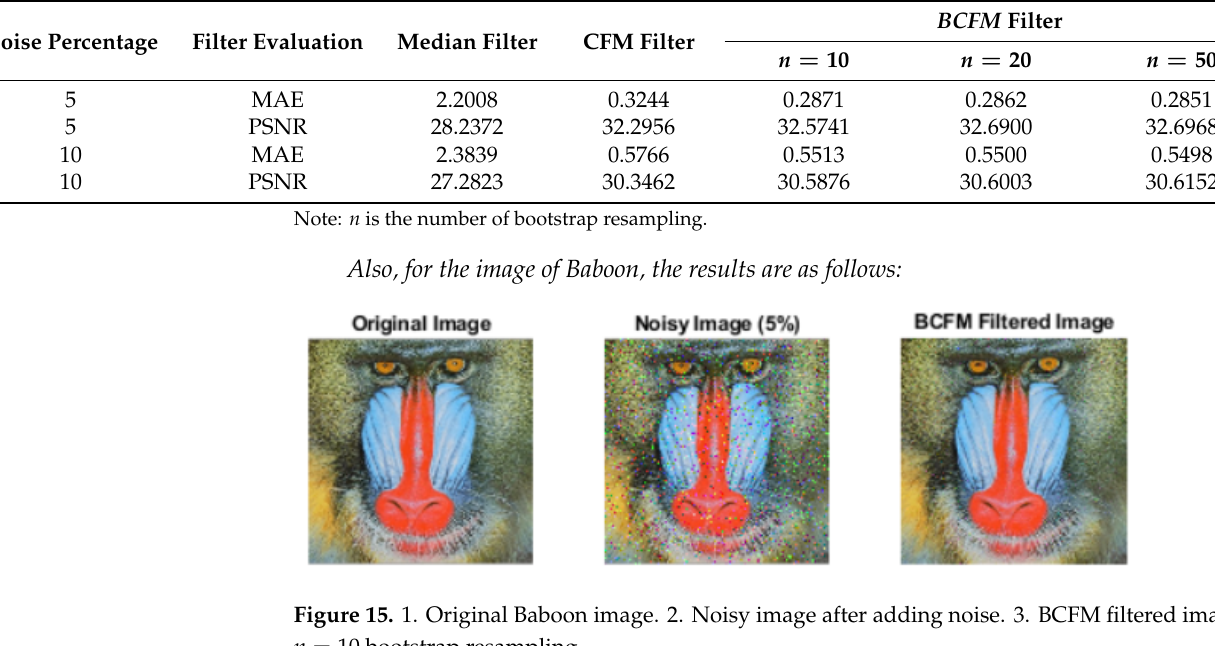
n = 10 bootstrap resampling. Table 3. Comparison of the performance of the noise reduction filters for the Baboon image.